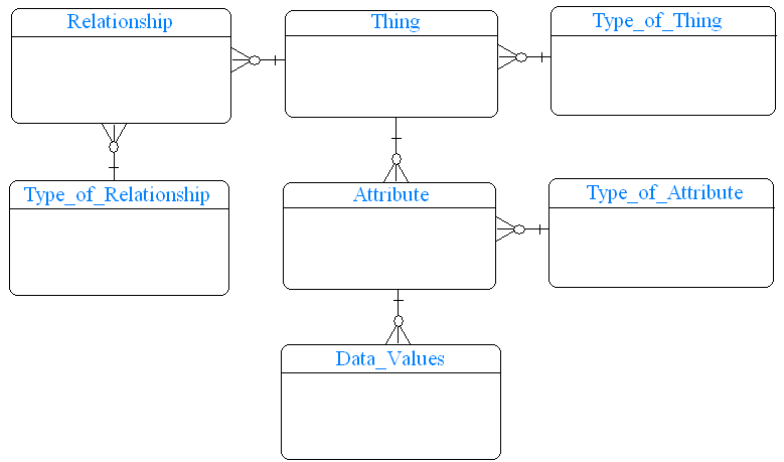
Figure 2. Example EAV conceptual data